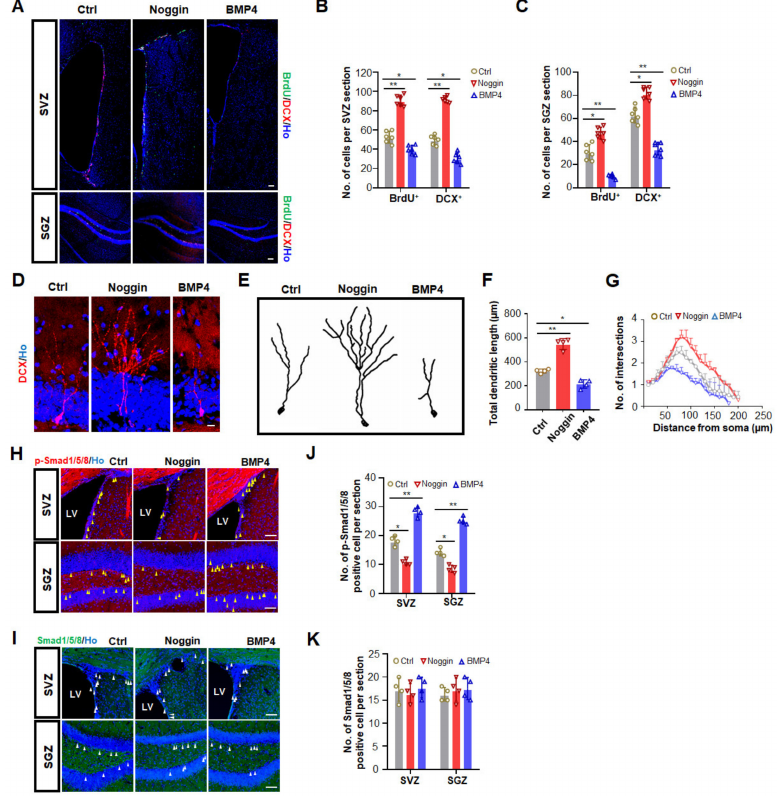
Figure 2. Canonical BMP4 signal inhibits adult neurogenesis in the SVZ and SGZ. ( A ) Representative images of BrdU and DCX positive cells in the SVZ and SGZ of 8 MO female mice one week after saline, a medium dose of noggin or BMP4 infusion. Scale bar, 100 µ m. ( B ) Quantification of BrdU and DCX positive cells in the SVZ from 8 MO female mice one week after saline, medium dose of noggin or BMP4 infusion. * p < 0.05 and ** p < 0.01. ( C ) Quantification of BrdU and DCX positive cells in the SGZ from 8 MO female mice one week after saline, a medium dose of noggin or BMP4 infusion. * p < 0.05 and ** p < 0.01. ( D ) Representative images of the morphology of DCX positive immature neurons in the SGZ of 8 MO female mice one week after saline and a high dose of noggin or BMP4 infusion. Scale bar, 10 µ m. ( E ) Image tracing of DCX positive immature neurons in the SGZ of 8 MO female mice one week after saline and a high dose of noggin or BMP4 infusion. ( F ) Quantification of the total dendritic length of DCX positive immature neurons in the SGZ of 8 MO mice one week after saline, a high dose of noggin or BMP4 infusion. n = 20–25 neurons from 3 mice. * p < 0.05 and ** p < 0.01. ( G ) Quantification of dendritic complexity of DCX positive immature neurons in the SGZ of 8 MO mice one week after saline, a high dose of noggin or BMP4 infusion. n = 20–25 neurons from 3 mice. ( H ) Representative images of p-Smad1/5/8 staining in the SVZ and SGZ of 8 MO female mice one week after saline, a high dose of noggin or BMP4 infusion. Scale bar, 50 µ m. Arrowheads refer to p-Smad1/5/8 positive signals. ( I ) Representative images of Smad1/5/8 staining in the SVZ and SGZ of 8 MO female mice one week after saline, a high dose of noggin or BMP4 infusion. Scale bar, 50 µ m. Arrowheads refer to Smad1/5/8 positive signals. ( J ) Quantification of p-Smad1/5/8 positive cells in the SVZ and SGZ from 8 MO female mice one week after saline, a high dose of noggin or BMP4 infusion. * p < 0.05 and ** p < 0.01. ( K ) Quantification of Smad1/5/8 positive cells in the SVZ and SGZ from 8 MO female mice one week after saline, a high dose of noggin or BMP4